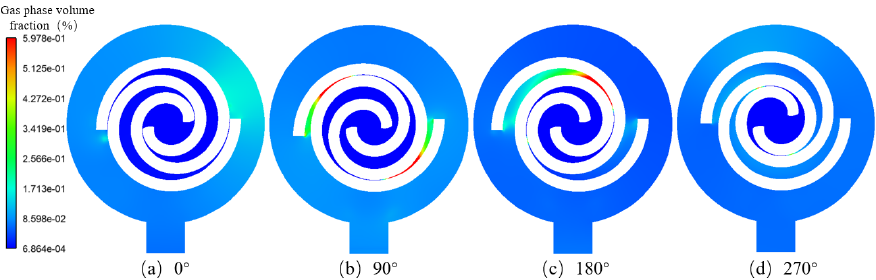
Figure 7. Gas ‐ phase volume fraction at different rotation angles.